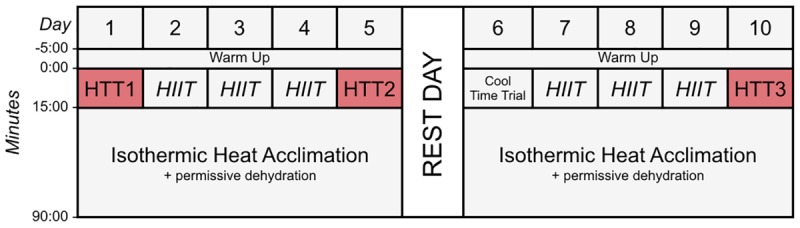
Schematic diagram of the time trials and heat acclimation sessions (HA). Time trials were conducted in hot conditions [HTT; 35°C, 30% relative humidity (RH)], before HA (HTT1), after 4-days (HTT2) and after 9-days (HTT3) HA. On days 2–4 and 7–9, participants completed 15-min of high-intensity intervals (HIIT), where maximum effort was given for 15-s, with 45-s of active recovery. Participants then undertook 75-min of isothermic heat acclimation (where exercise intensity was manipulated to increase and maintain rectal temperature at ∼38.5°C; 40°C, 30%RH) with permissive dehydration. There was one rest day following 5-days HA. Cool Time Trial refers to a 15-min cycling time trial in cool conditions (15°C, 30% RH), which was part of a larger dataset that are not reported herein.